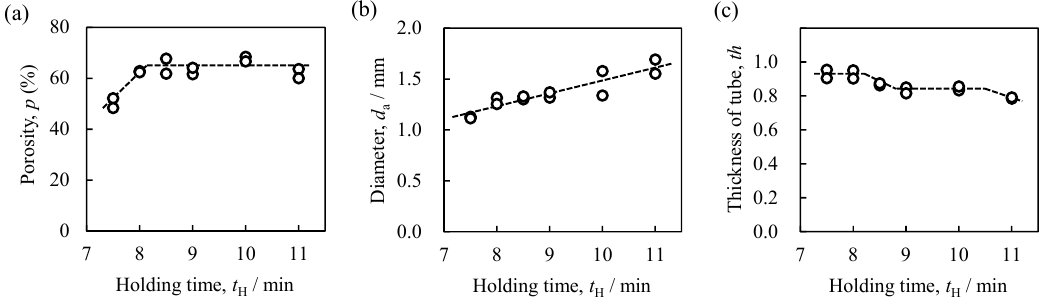
Figure 6. ( a ) Porosity p ; ( b ) pore diameter d a ; and ( c ) thickness of the A1050 tube th of fabricated ADC12 ‐ foam ‐ filled A1050 tubes as function of holding time t H .